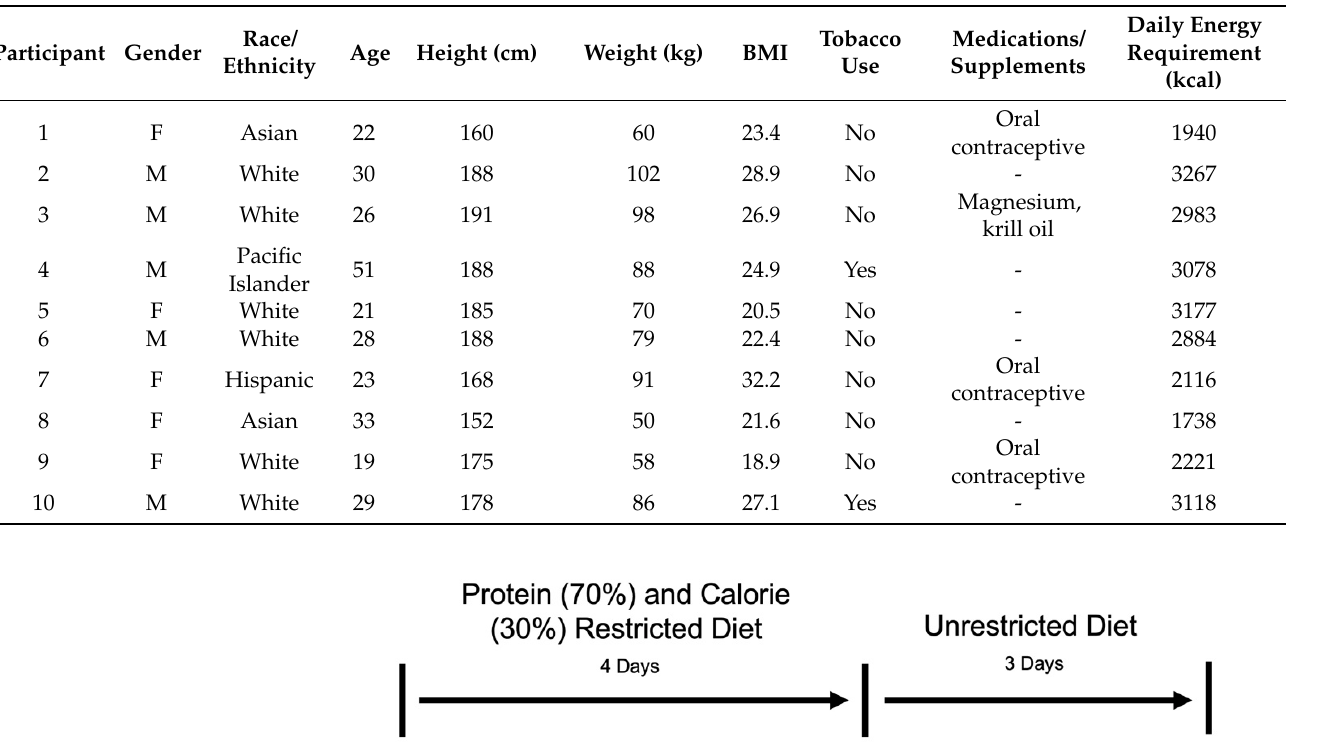
Table 1. Participant characteristics.